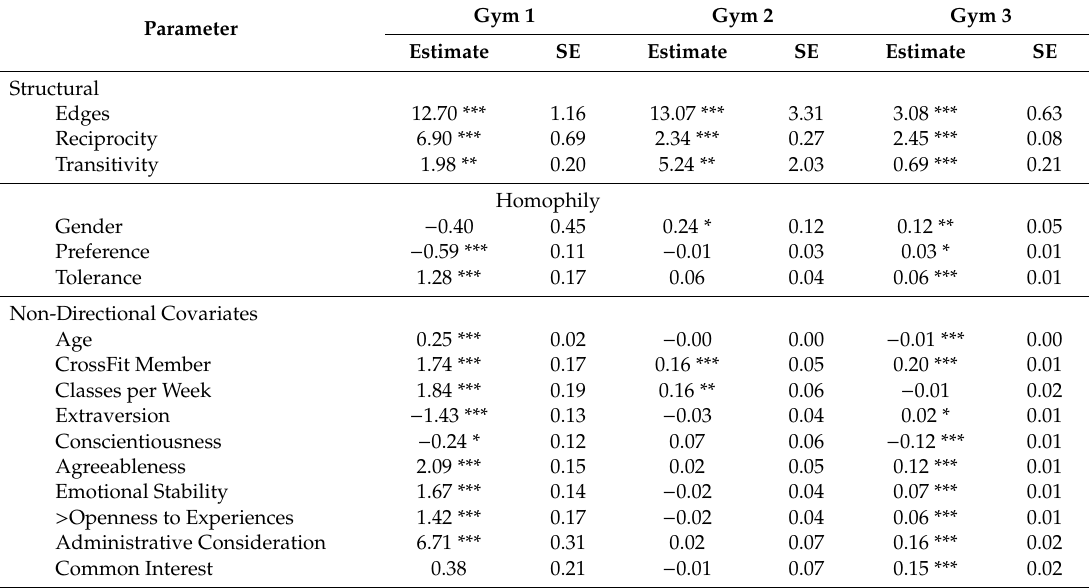
Table 4. Exponential random graph models assessing factors related to tie presence in three CrossFit